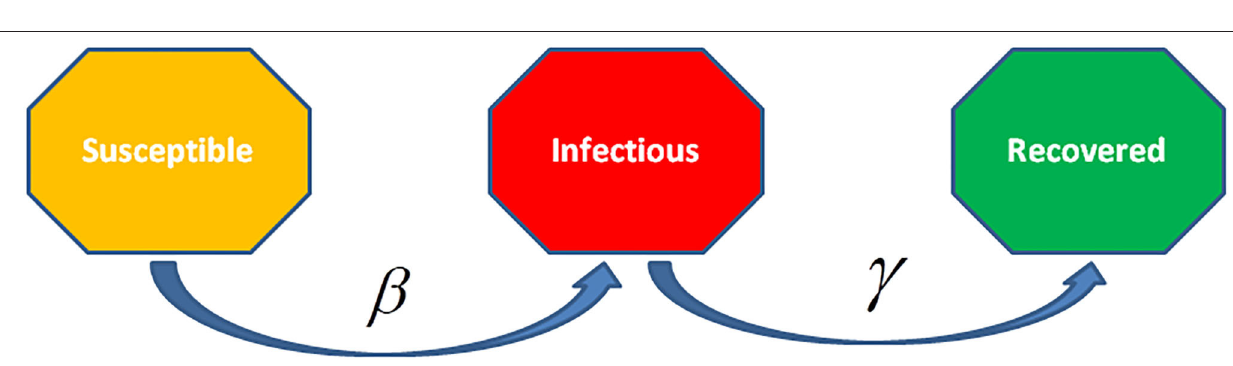
FIGURE 8 | The Susceptible-Infected-Recovered (SIR) model is an epidemiological model that computes the theoretical infections with a contagious infection in a closed population over time. The family of these models involves coupled equations related to the number of susceptible people, infected cases, and recovered individuals from the